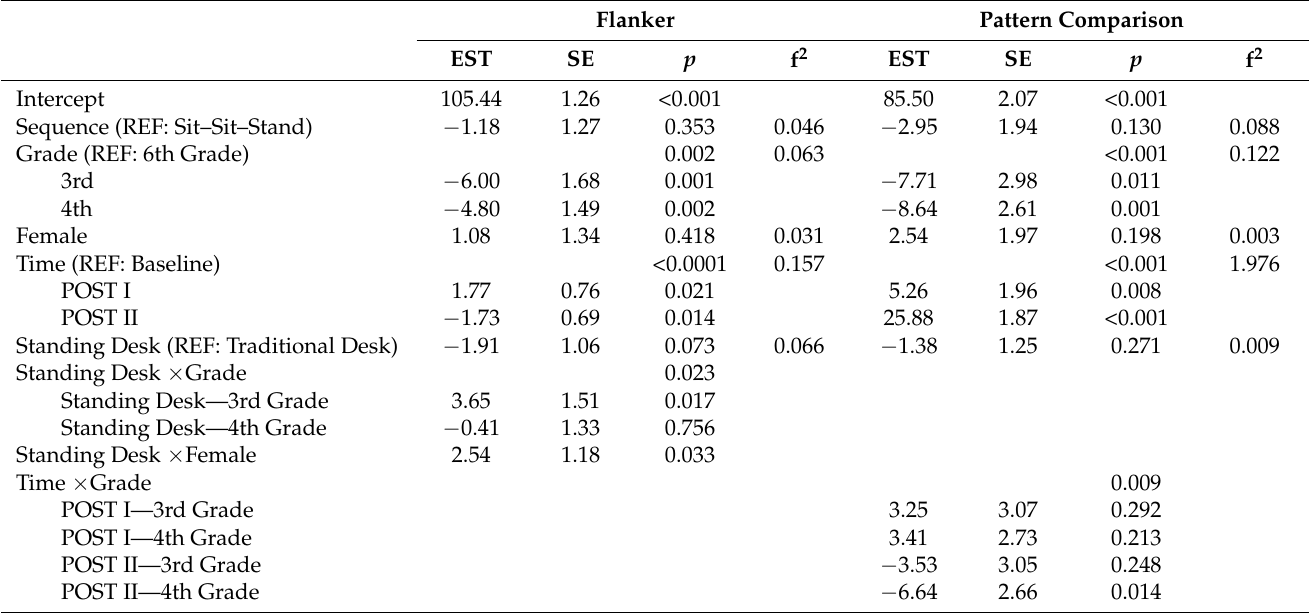
Table 3. Models of Significance.